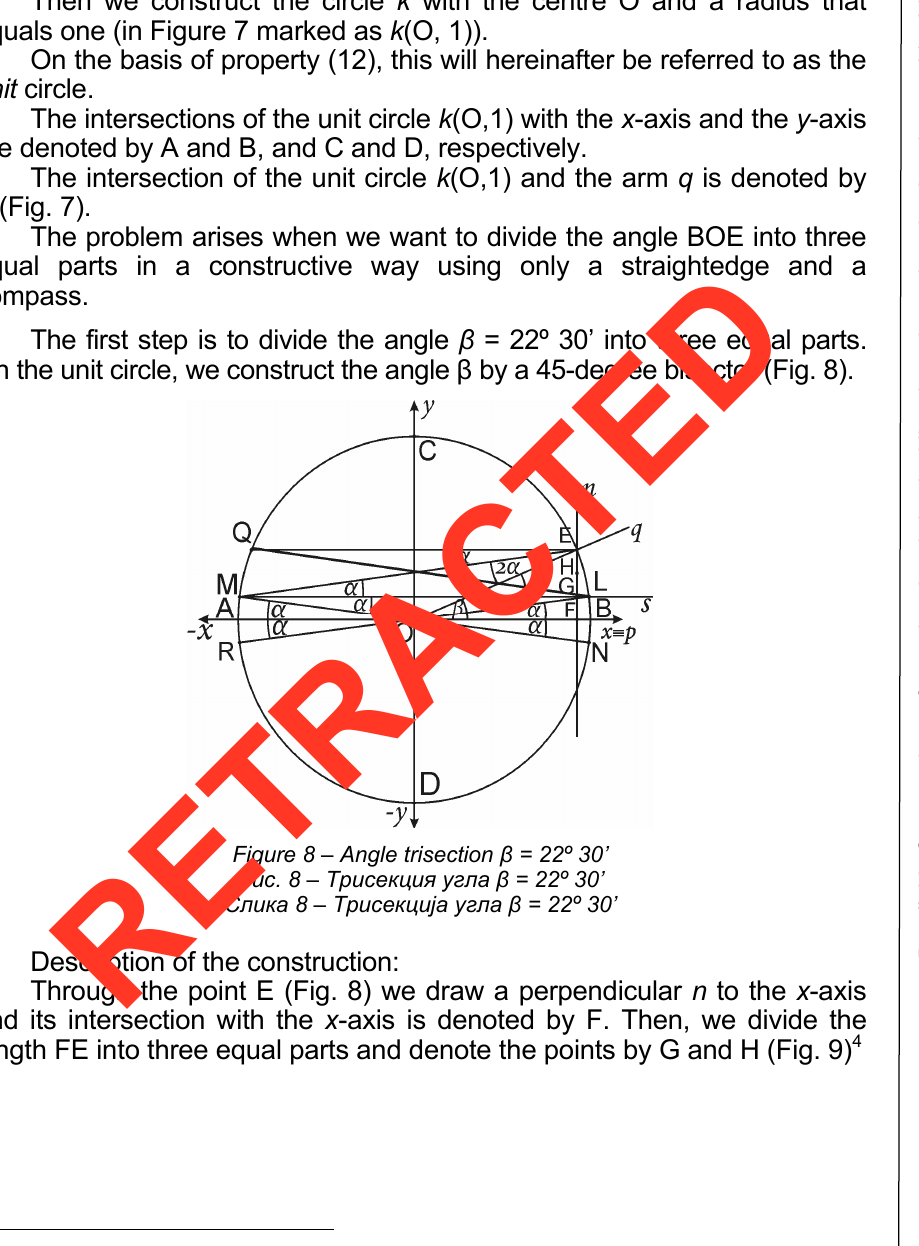
Figure 8 – Angle trisection β = 22º 30’ Рис . 8 – Трисекция угла β = 22º 30’ Слика 8 – Трисекција угла β = 22º